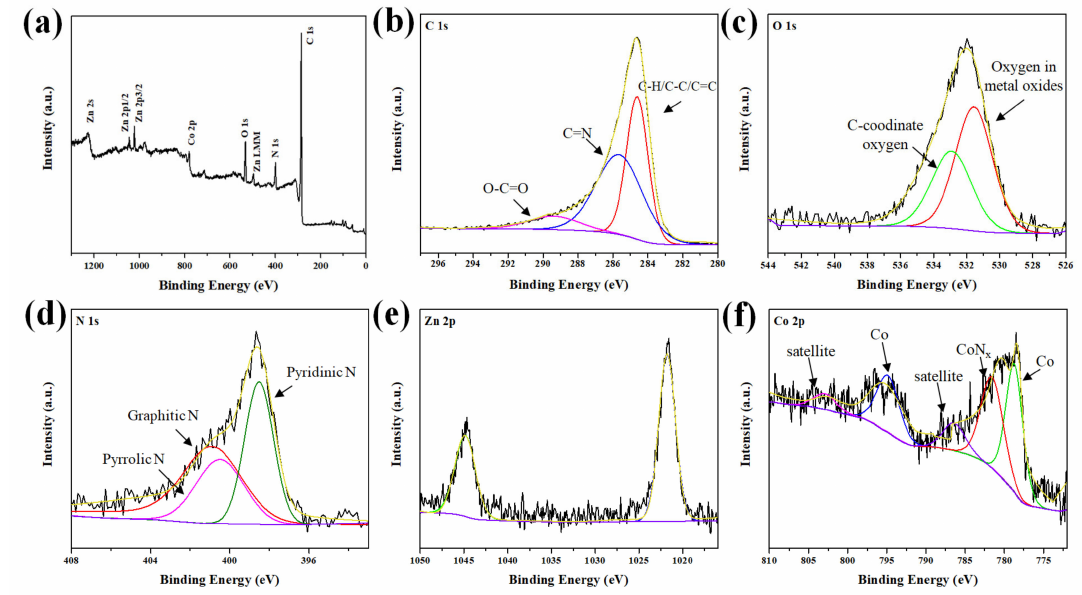
Figure 6. XPS spectra of Co/ZnO-NC: ( a ) survey scan spectrum, ( b ) high-resolution C 1s spectrum,